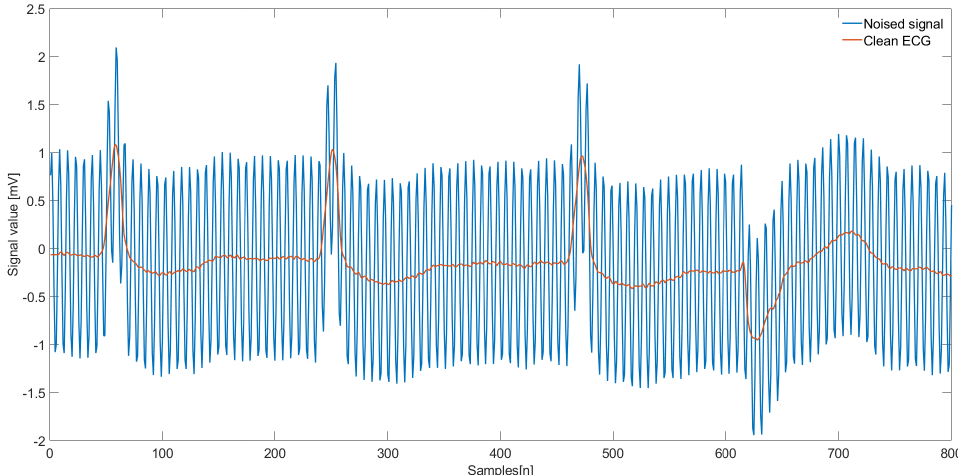
Figure 7. ECG 2 signal disturbed by the power line interference, and the distortion-free